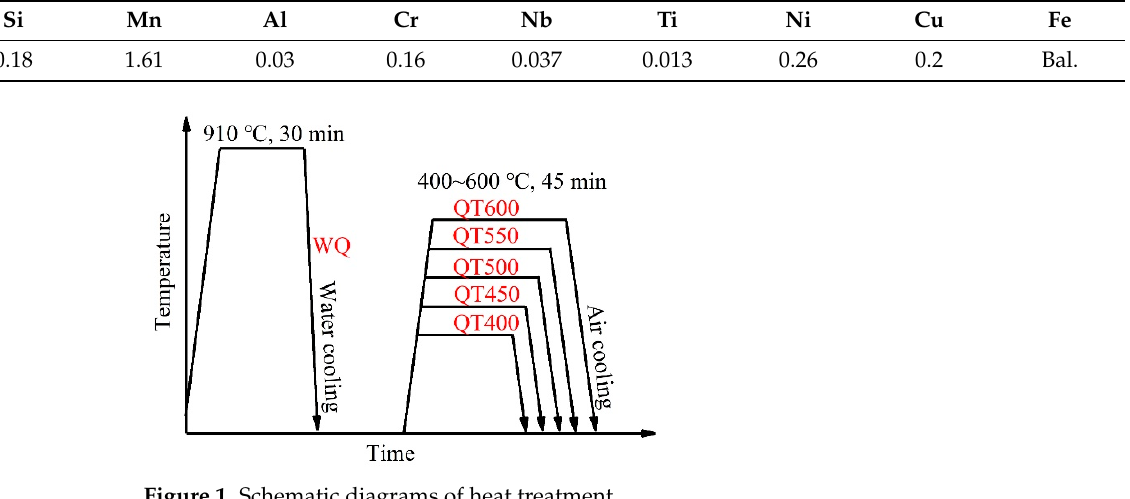
Table 1. Chemical composition of the experimental steel (wt.%).